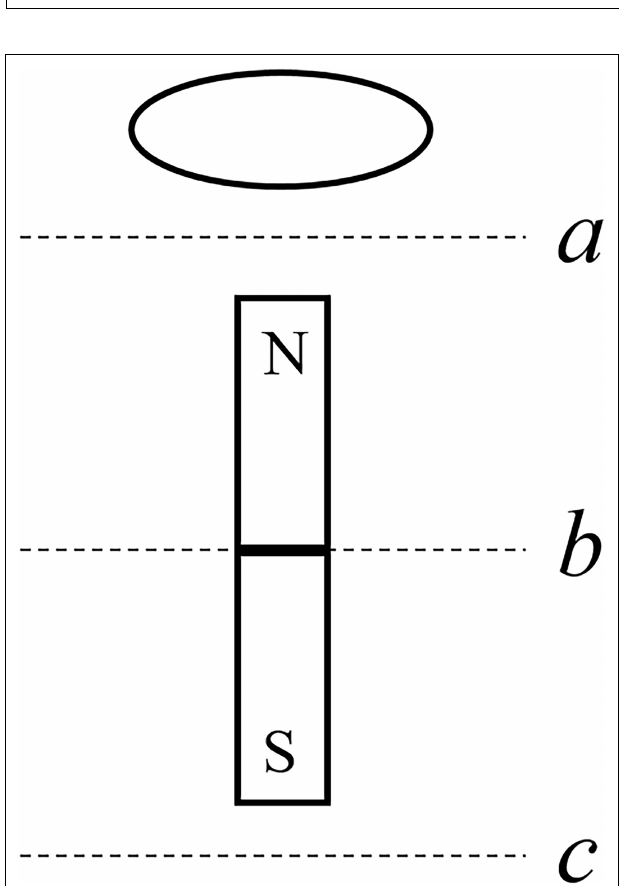
FIGURE 8 | The physical situation circuit of (LL1, LL2) = (10) level remedial teaching